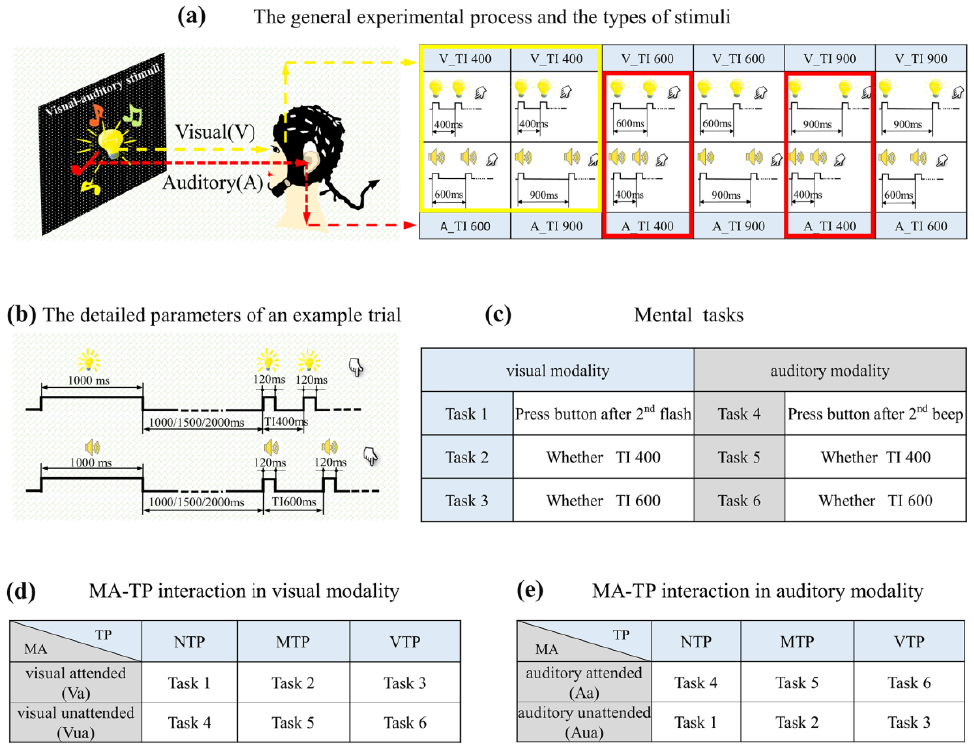
Figure 1. Illustration of the experimental design: ( a ) The general experimental process: There were six kinds of visual–auditory combinations in total, which are listed in the table. The yellow and red boxes indicate the trials selected for visual and auditory analyses, respectively. ( b ) An example of the detailed parameters. ( c ) The list of mental tasks, with 1–6 used to represent the tasks described above. These numbers did not represent the presentation order of the tasks. ( d ) The manipulation of modality attention (MA) and precise timing prediction (TP) in visual, and ( e ) auditory